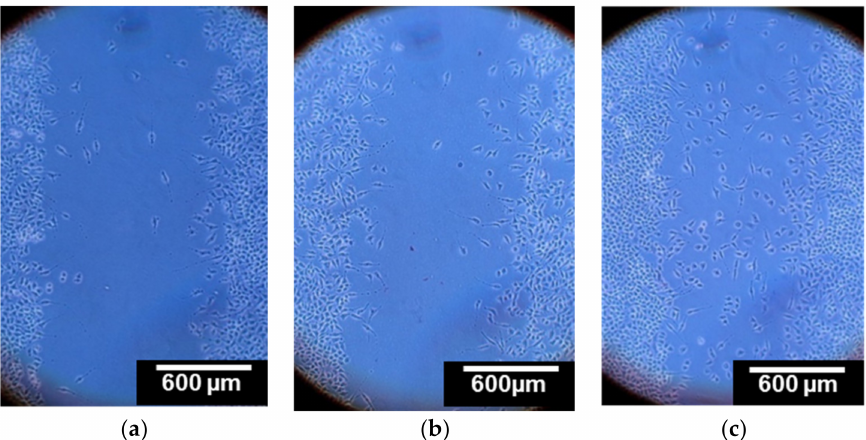
Figure 7. Scratch assay with L929 mice fibroblast cells after 24 h in serum-free culture medium without any scaffold under microscope at 10 × magnification, ( a ) with dissolved non-stabilized chitosan scaffold, ( b ) and with curdlan–chitosan scaffold ( c ). The images are representative of 3 independent experiments.